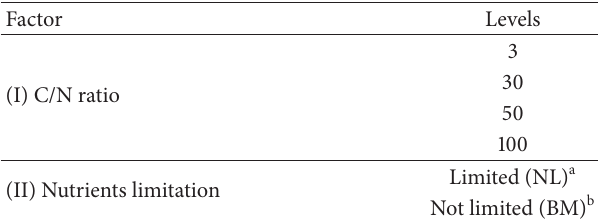
Table 2: Experimental design (bifactorial with two replicates) to investigate the effect of nutrients and C/N ratio on EPS